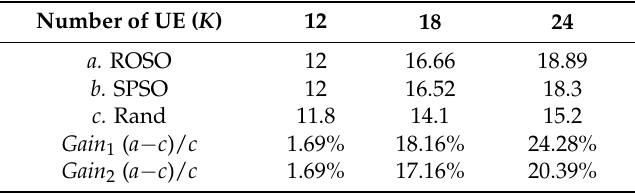
Table 3. The comparisons between RPSO, SPSO and Rand.